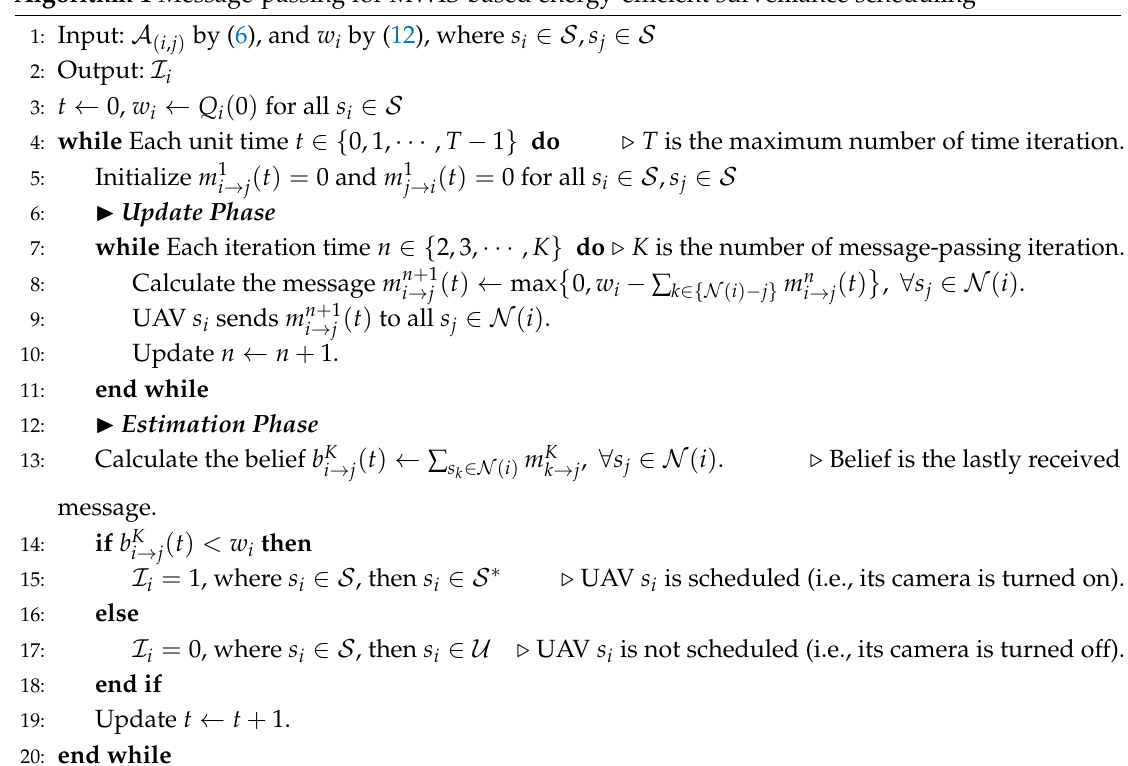
Algorithm 1 Message-passing for MWIS-based energy-efficient surveillance